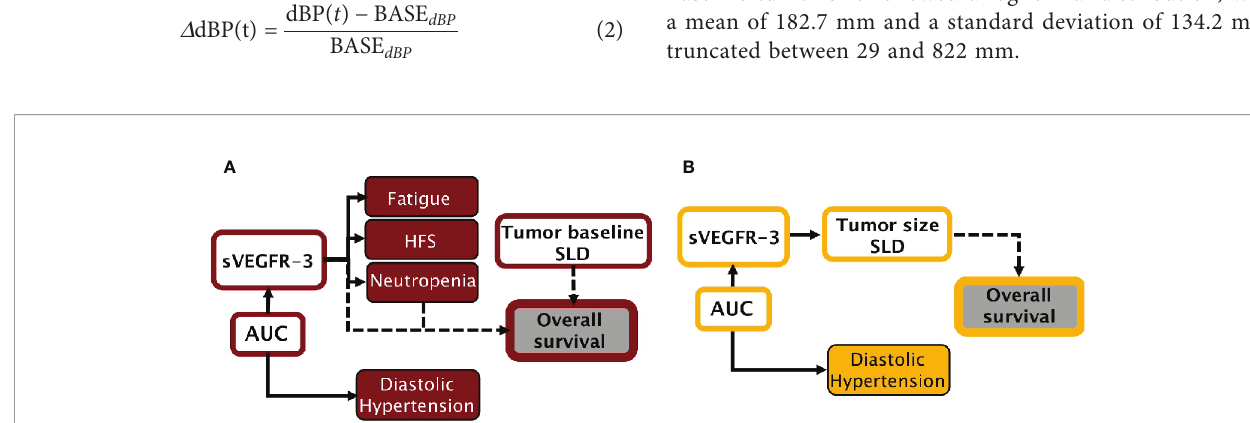
FIGURE 1 | Simulation frameworks. (A) Model-based framework for sunitinib in GIST, adapted from previous work (Hansson et al., 2013a; Hansson et al., 2013b). (B) Model-based framework for axitinib in mRCC, adapted from previous work (Schindler et al., 2017). AUC, area under the plasma drug concentration-time curve; dBP, diastolic blood pressure; HFS, hand-foot syndrome; SLD, sum of longest diameters (tumor); sVEGFR-3, soluble